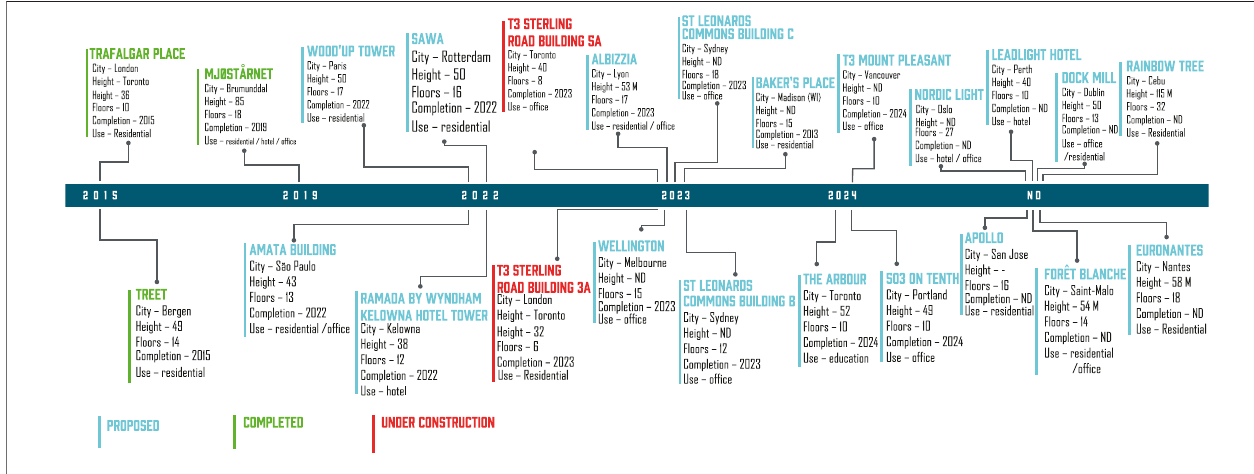
FIGURE 1 | Evolution of tall-timber design and construction (compiled from the Council on Tall Buildings and Urban Habitat database on January 1, 2022).